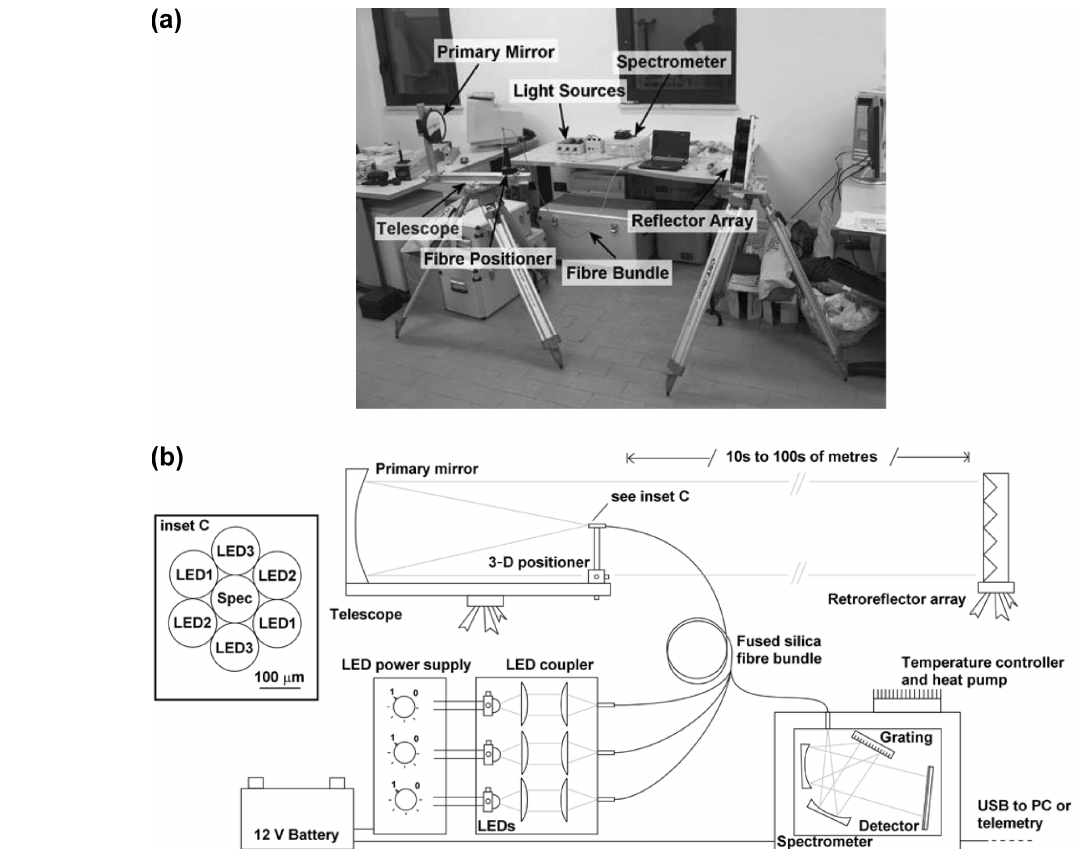
Figure 1. Photograph (a) and schematic (b) of the portable active long-path DOAS instrument. Light from three UV LEDs is coupled to a fibre bundle, collimated to a parallel beam and sent to an array of reflectors. Upon returning, it is coupled to a moderate-resolution UV spectrometer for analysis of absorption